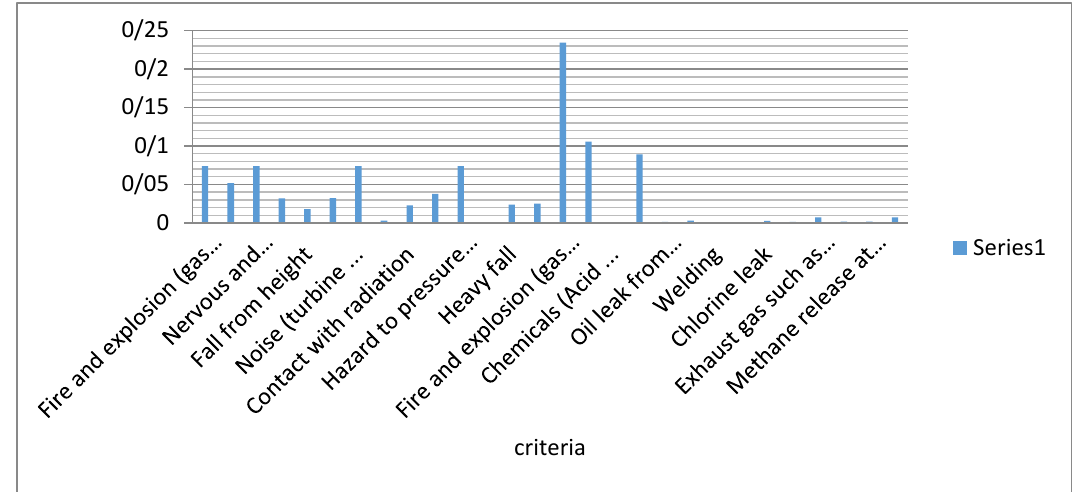
Figure 6. Weights below criteria